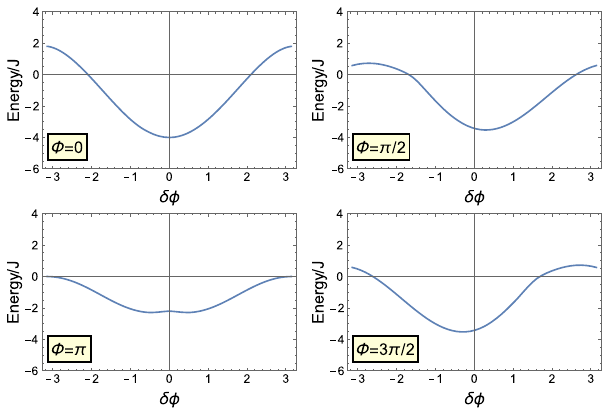
FIG. 4. Potential energy vs the superconducting phase differ- ¯ ϕ ence δϕ ¼ ϕ 1 − ϕ 2 [minimized over ¼ ð ϕ 1 þ ϕ 2 Þ = 2 ], plotted for a junction twice as strong as the average of the other two ( λ ¼ 2 ) and a Josephson asymmetry ϵ ¼ 0 . 1 , and various values of Φ . As Φ is tuned from 0 to 2 π , a magnetic flux is drawn into the superconducting loop. Note the degeneracy at Φ ¼ π